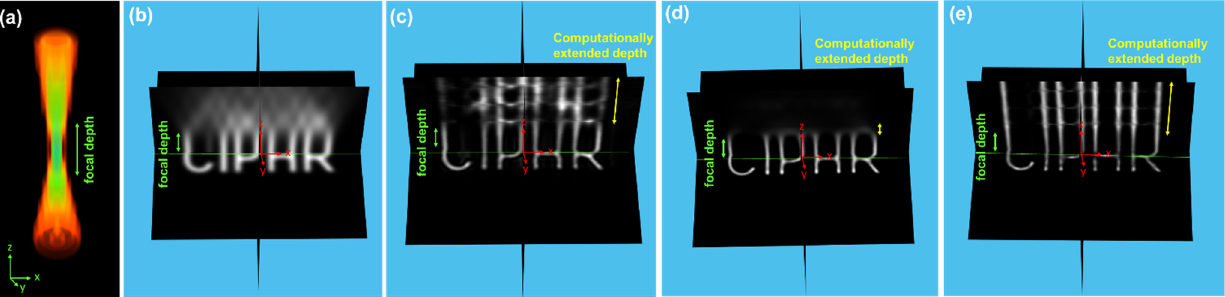
Figure 4. ( a ) Image of 3D PSF ( z s = 0.6 to 1 m), X-Y cross sectional images obtained from cube data of ( b ) imaging using a lens, reconstruction using ( c ) NLR, ( d ) LRA and ( e ) LRRA.